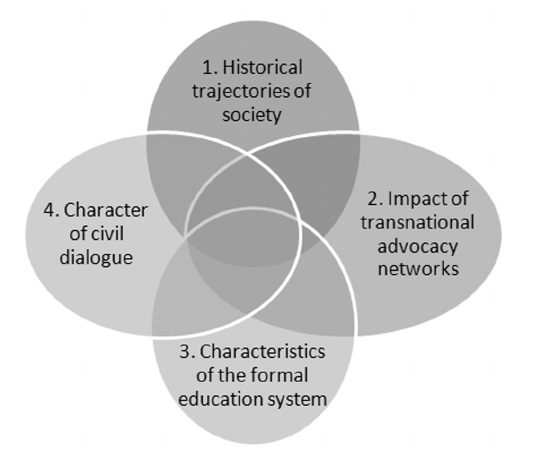
Figure 1: Key factors contributing to the shape of the Polish agreement on global